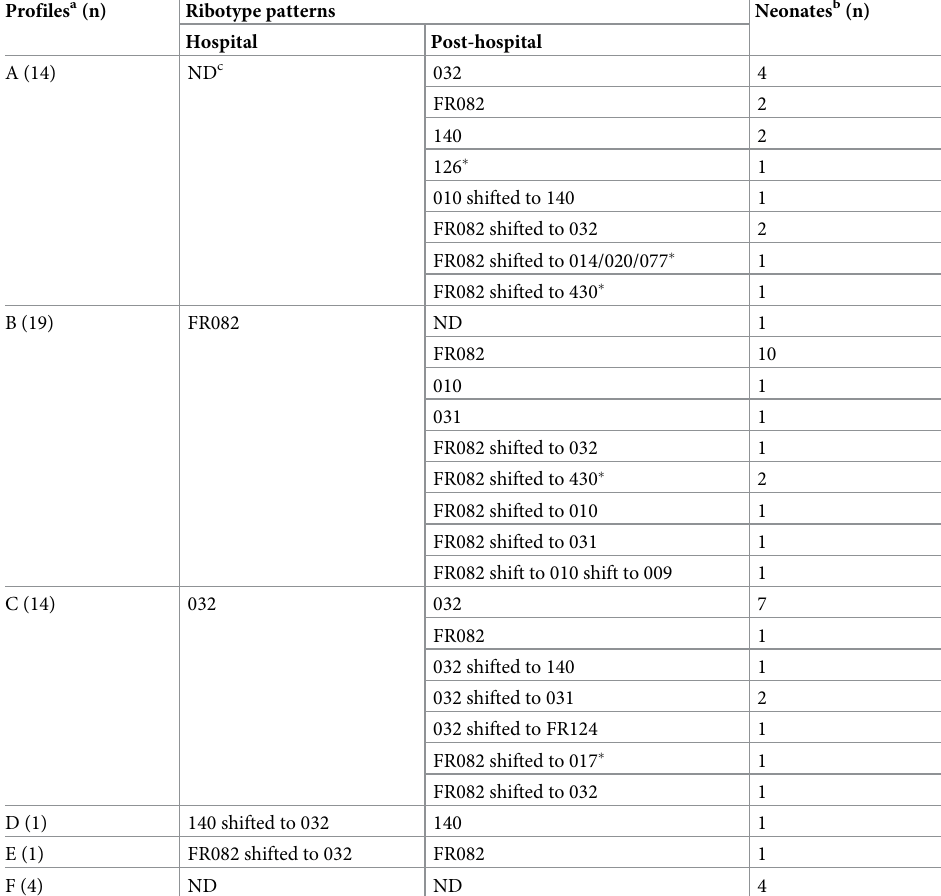
Table 2. C . difficile ribotype colonization patterns among the preterm neonates during the hospitalization and post-hospitalization